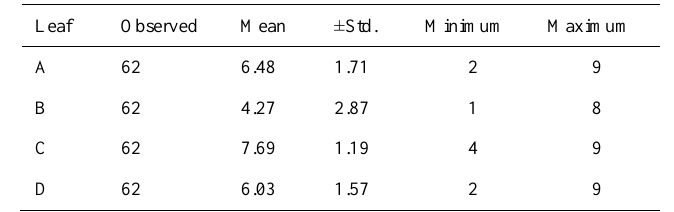
Table 3. Summary statistics for the leaf liking score ratings by the 62